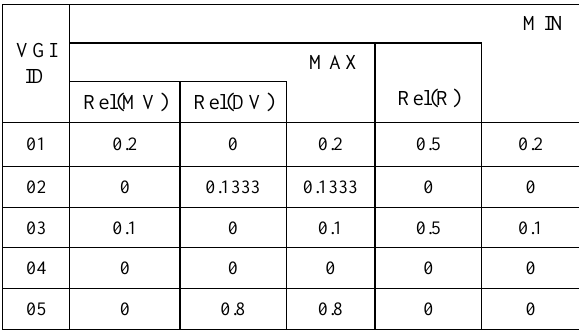
Table 5: partial and final ranks of the VGI items in Table 3 with elementary quality indicators in Table 4 with respect to the simulated query defined by formula